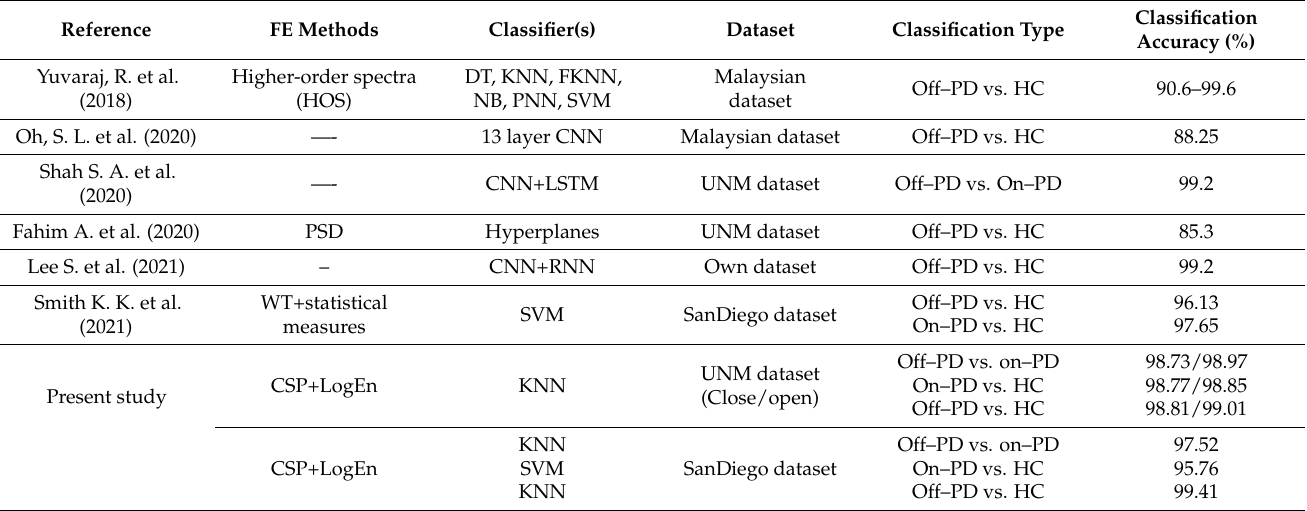
Table 16. Comparisons of our results with the results of previous studies